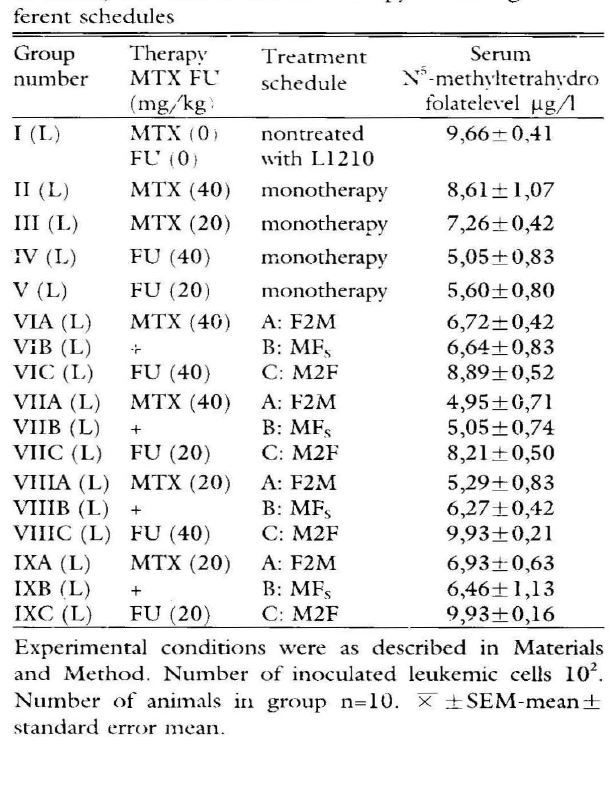
Group symbols as in Table 9. Significance level set at p S O.OS.